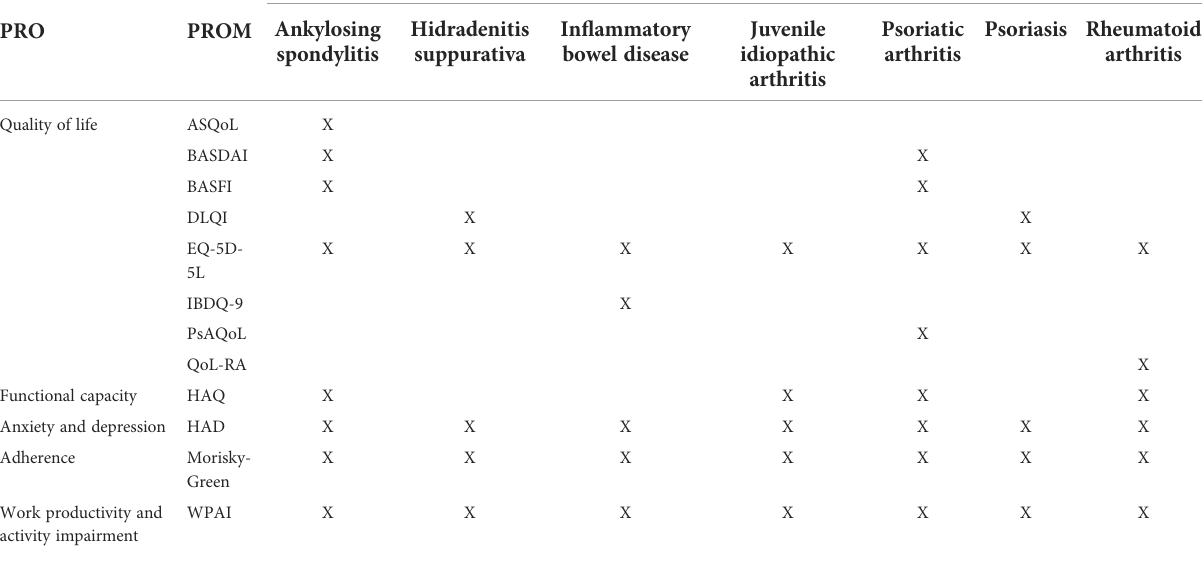
TABLE 1 Patient-reported outcomes assessed by the